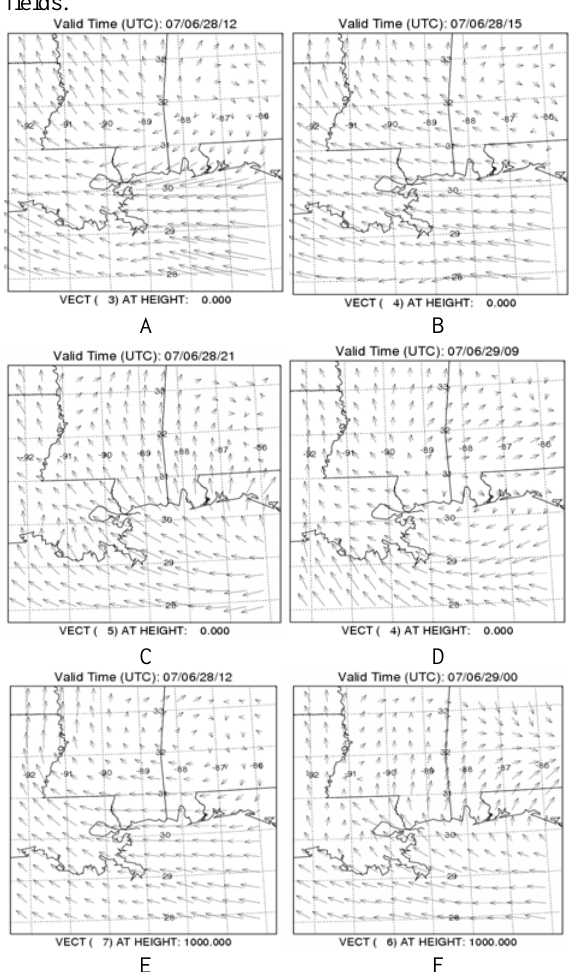
Figure 10: Observed wind flow pattern from NCEP NAM analysis for 28-29 June 2007. Panels a,b,c,d- for surface wind and panels e, f- for winds at 1km.